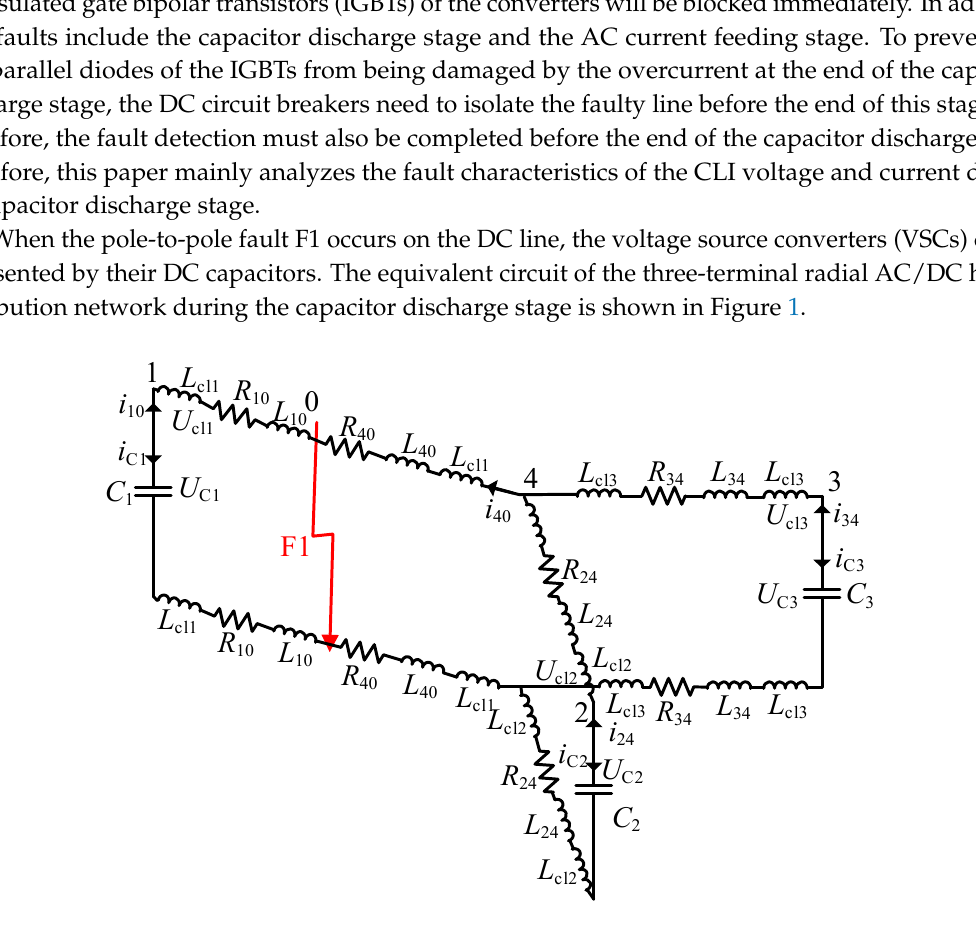
Figure 1. Equivalent circuit for fault F1 of the multi-terminal radial AC/DC hybrid distribution network.